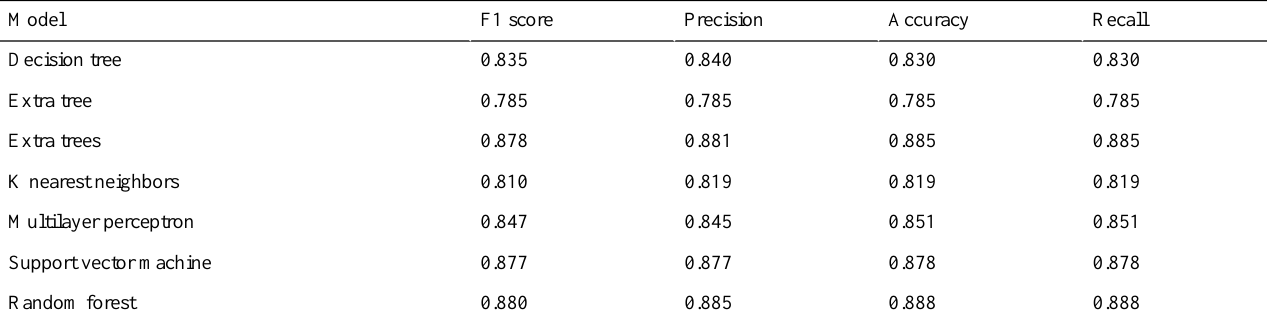
Table 1. Performance of machine learning models in classifying sick posts.